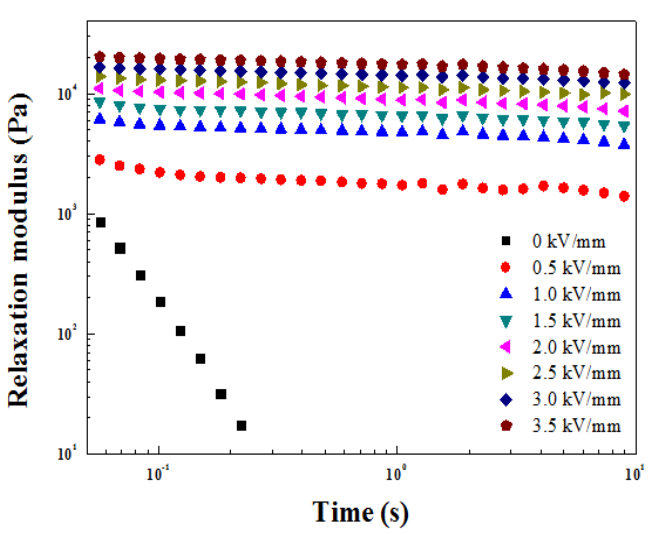
Figure 10. G(t) of ZnFe 2 O 4 /PMA-based ER fluid calculated from G’ and G” in the frequency sweep measurement.